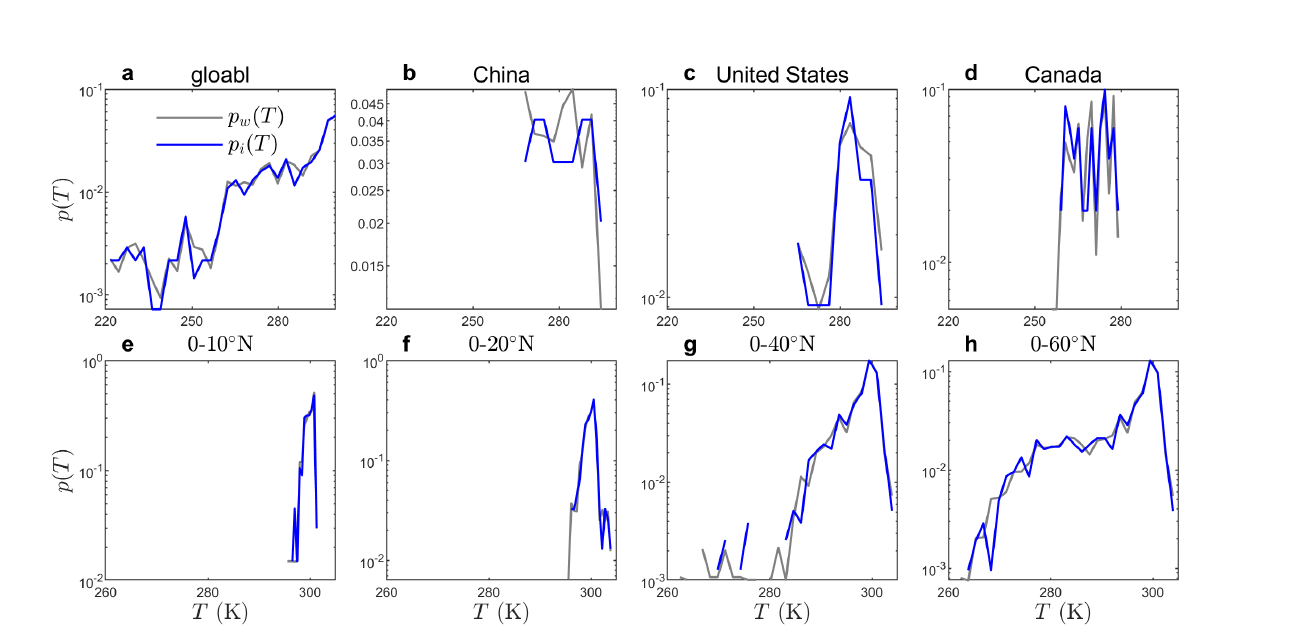
Figure 10. As in Figure 8 but for HadTEMSST